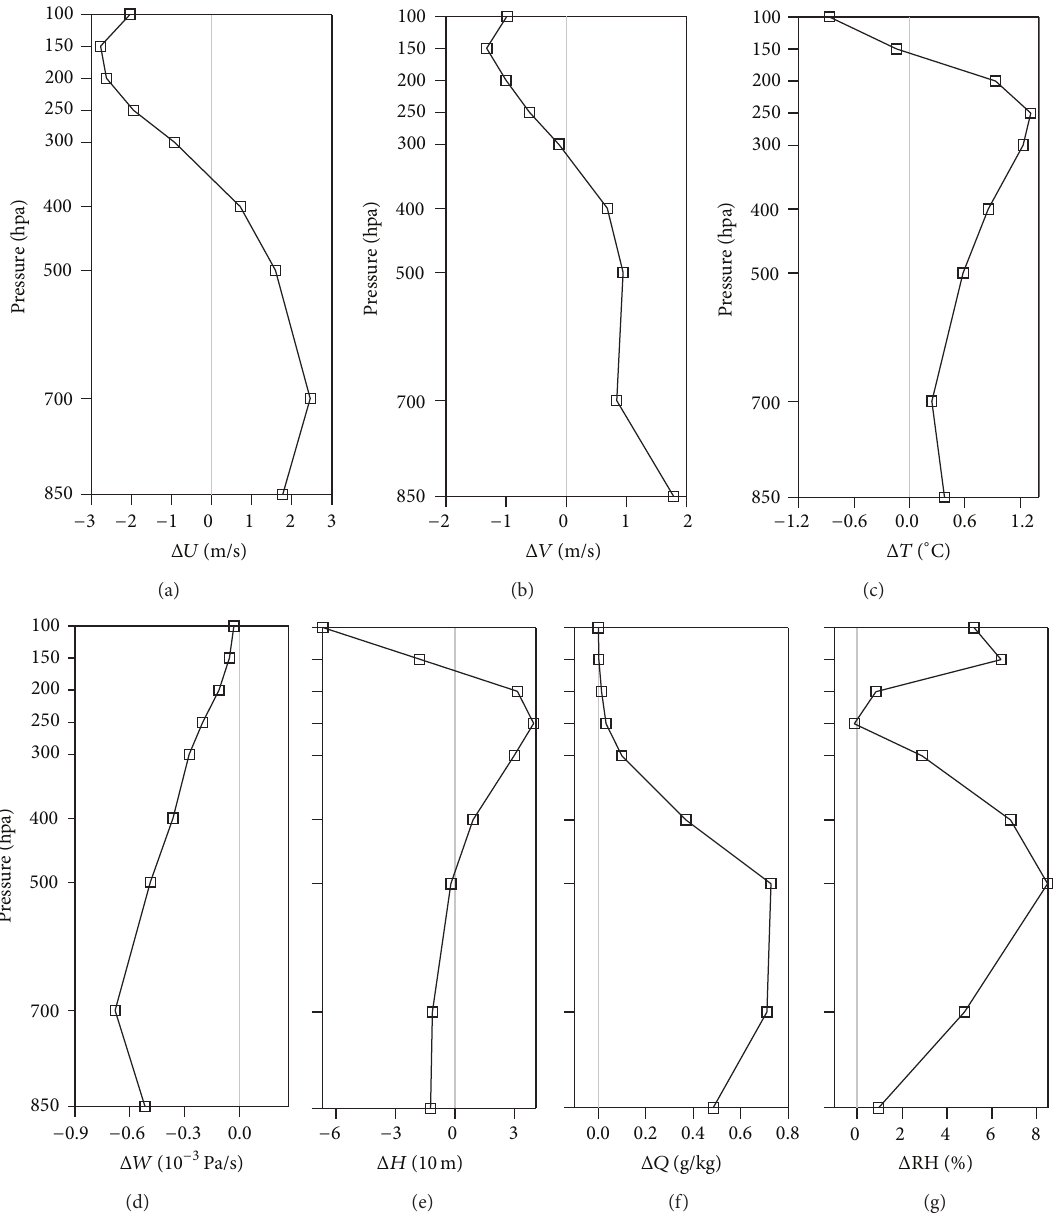
Figure 6: The profiles of the 10-year summer mean differences between BATS and CLM for (a) zonal wind 𝑈 , (b) meridional wind 𝑉 , (c) air temperature 𝑇 , (d) vertical velocity 𝑊 , (e) geopotential height 𝐻 , (f) water vapor mixing ratio 𝑄 , and (g) relative humility RH over the